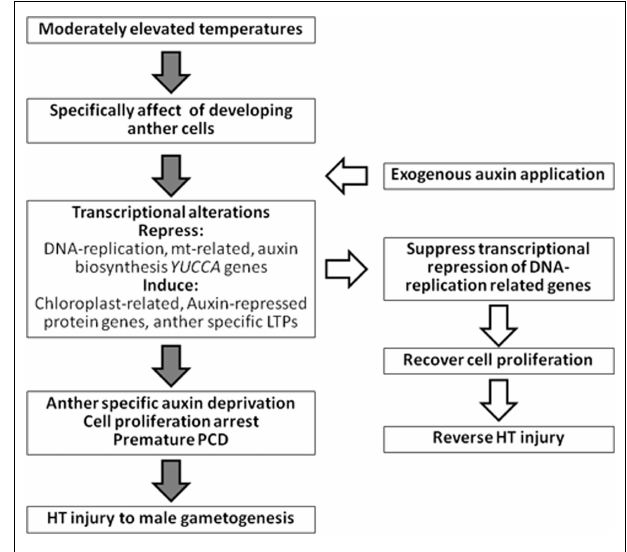
FIGURE 1 | Summary of HT injury to anther early development and effect of exogenous application of